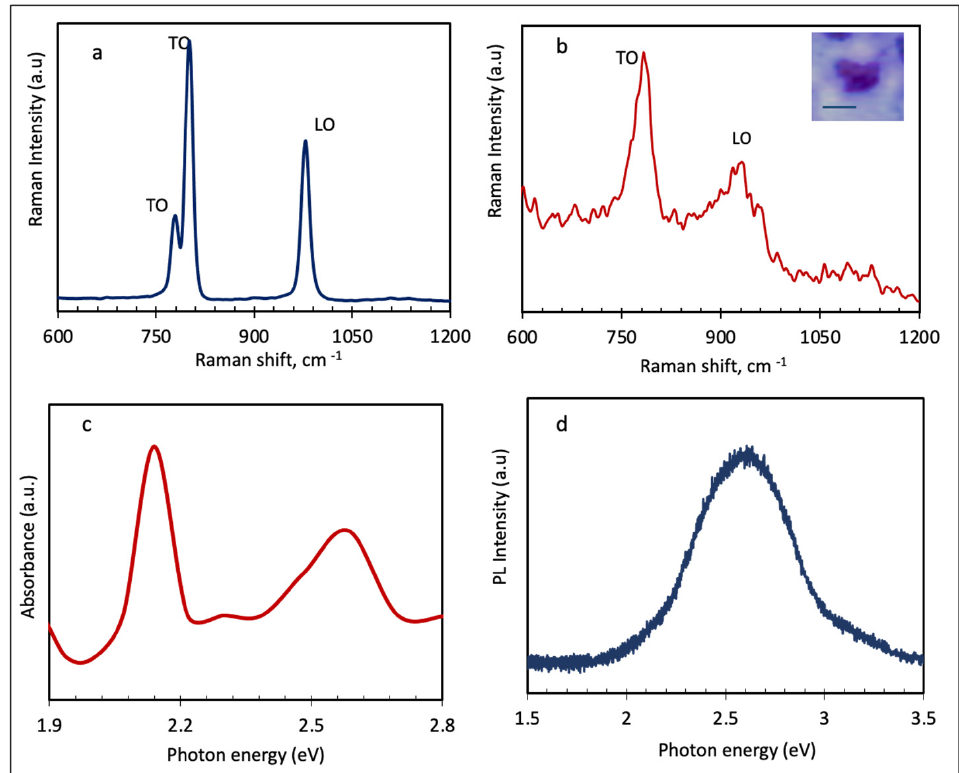
Figure 4. ( a , b ) Raman spectra of SiC precursor and exfoliated SiC nanosheets, respectively. The inset of image b shows an optical image of the tested SiC nanosheets prior to the measurement. The scale bar in the inset of 4b is 500 nm. ( c ) optical absorption spectrum of 2D SiC dispersion. ( d ) Photoluminescence spectrum of drop-casted SiC nanosheets on a sapphire substrate.